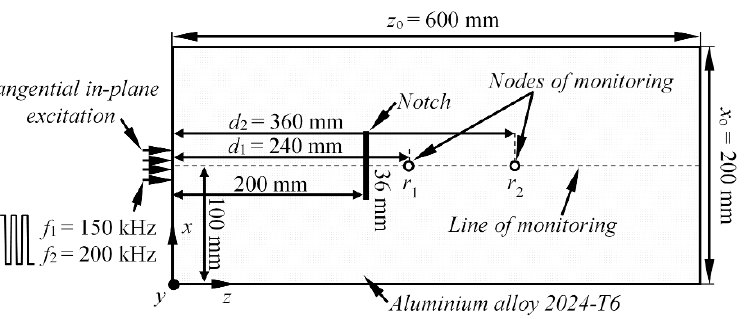
Figure 7. Illustration of the set-up of numerical aluminium plate FE model with the notch.